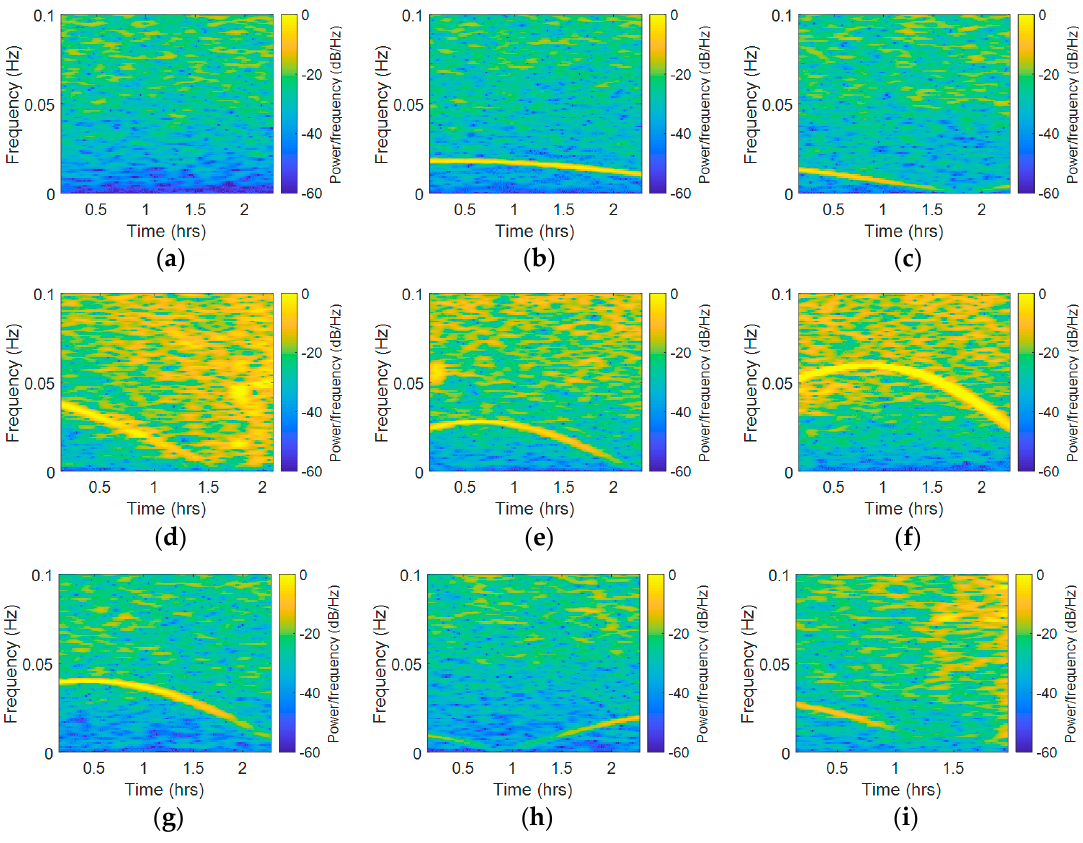
Figure 10. Short-time Fourier transformation (STFT) results of the nine satellites from BDS, GLONASS and GPS systems (Site A, ( a ) C01, ( b ) C06, ( c ) C08, ( d ) R04, ( e ) R05, ( f ) R20, ( g ) G02, ( h ) G05, and ( i ) G06).